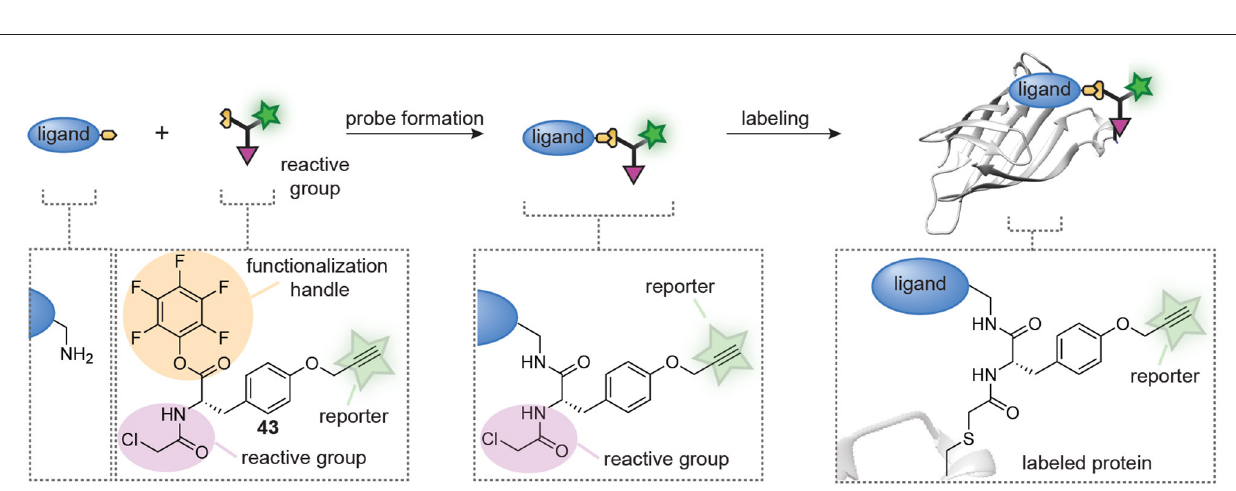
FIGURE 11 | Schematic representation of in situ probe formation with a pentafluorophenyl (PFP) ester-functionalized trifunctional reagent ( 43 ). An amine-containing ligand reacts with the PFP ester to introduce a cysteine reactive chloroacetamide and an alkyne bioorthogonal tag. The resulting probe is used without further purification. Probe labeling is visualized via a copper-catalyzed click reaction with a reporter